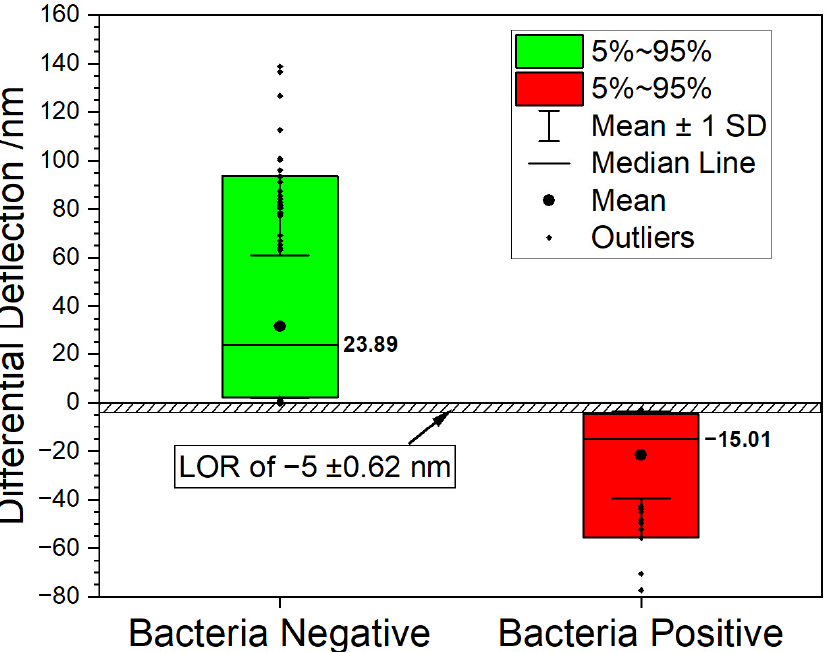
Figure 3. Boxplot graph summarizing the measurements. 90% of all datapoints fall inside the box. The bacteria negative samples (green box) shows a median value of 23.89 nm vs. a median value of − 15.01 nm for the bacteria positive samples (red box). The graph shows that the two populations can be clearly distinguished, suggesting a rejection level above − 5 nm with a signal to noise ratio of 8:1.